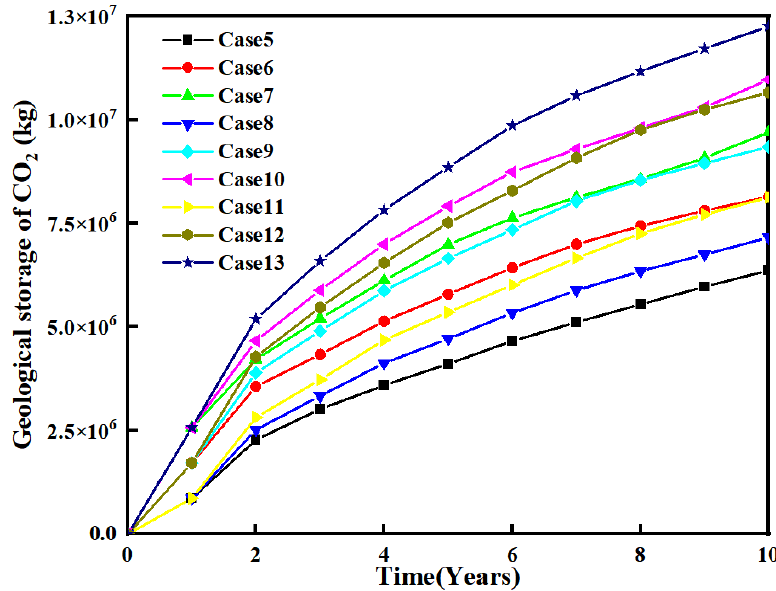
Figure 10. CO 2 geological storage curve of each